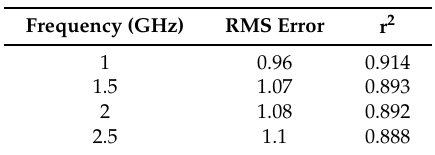
Table 2. Results for prediction of moisture content using β , phase delay (density included as